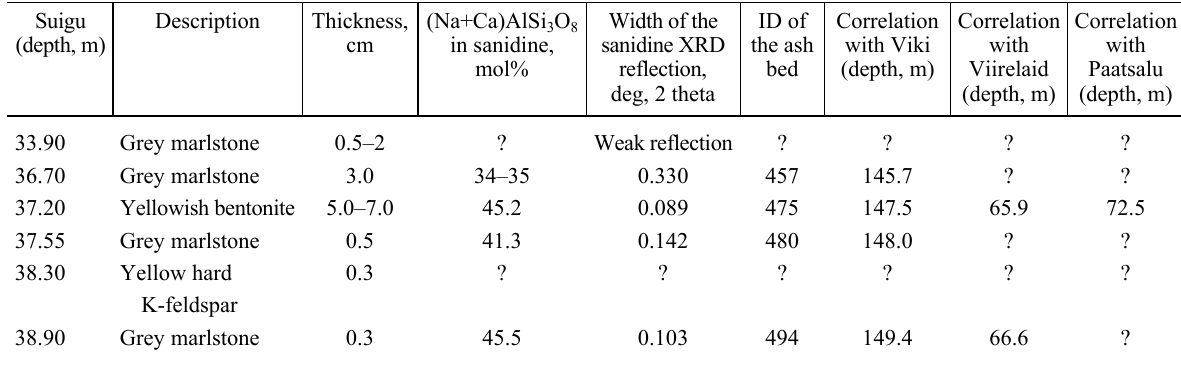
Table 1. General characteristics and geochemical correlation of volcanic material from the Suigu (S-3) core section. The question mark shows that no information is available Suigu (depth,